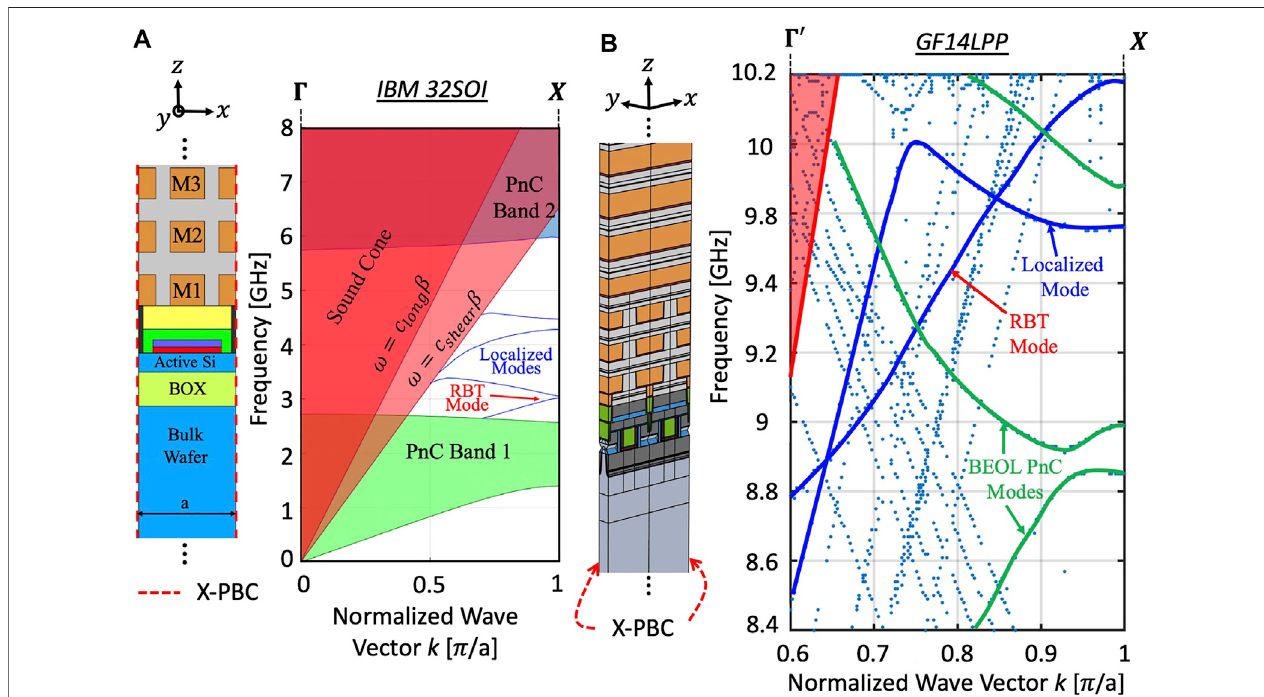
FIGURE 4 | (A) A single waveguide 2D unit cell with x-direction periodic boundary conditions corresponding to the IBM12RF process together with its bandstructure showing various modes that exist and the sound cones. This fi gure is a reprint of Figure 3 in (Bahr and Weinstein, 2016) reprinted with the permission of the Transducer Research Foundation (B) A 3D waveguide unit cell for the fi n-Resonant Body Transistor (fRBT) device implemented in the GF14LPP process and the corresponding bandstructure with different modes.